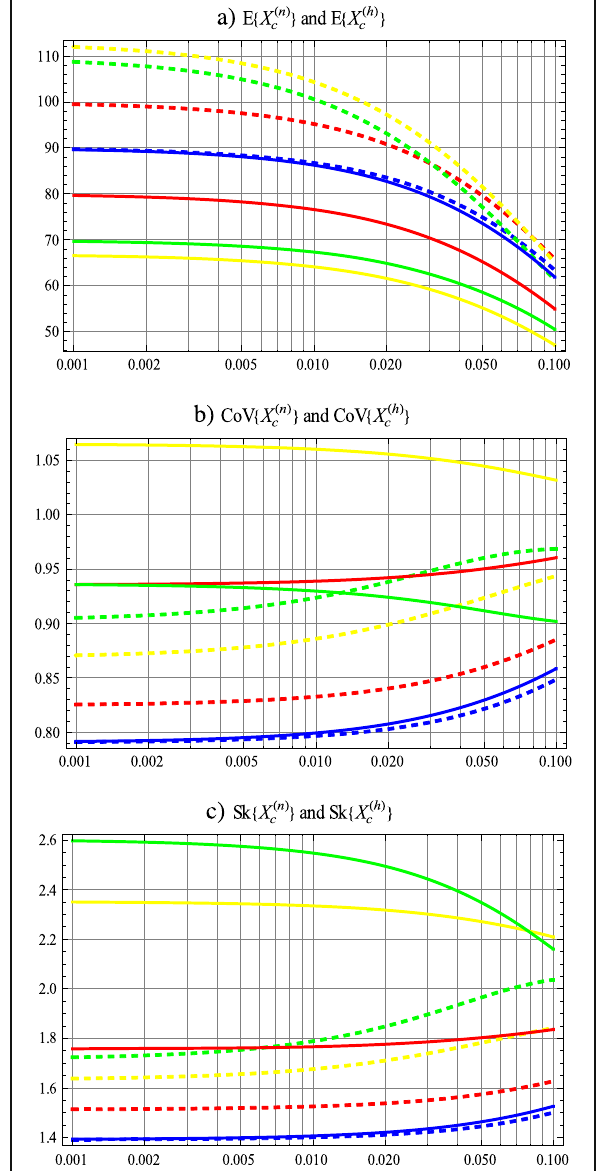
Fig. 7 a – c CHT statistics as a function of the interruption probability for different distributions of the UST when CDT is Erlang distributed. In this figure, red , blue , yellow , and green lines represent the scenarios where the UST is exponentially, Erlang, hyper-exponentially of order 2, and hyper-Erlang of order (2, 2) distributed, respectively. Solid-lines ( dashed-lines ) corresponds to CHTn (CHTh)